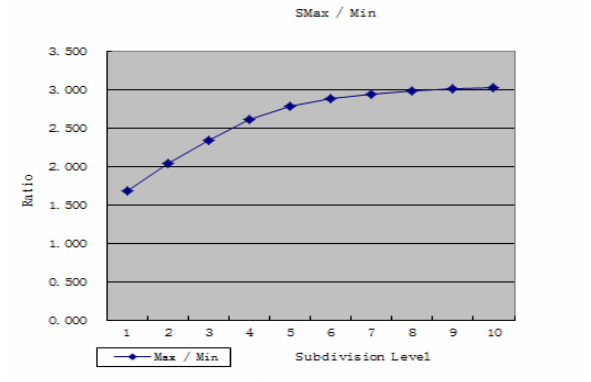
Figure 10 the ratio of max and min triangle